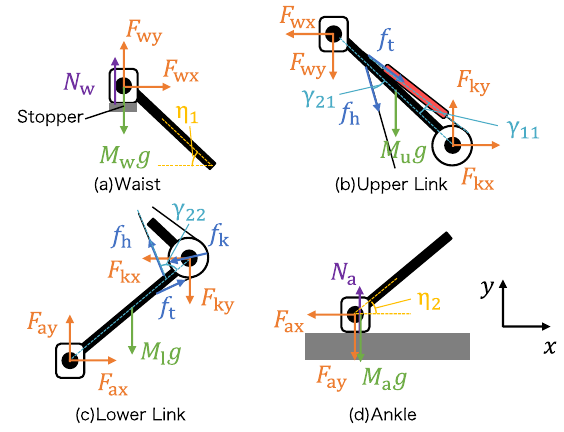
Fig. 5 Forces acting on each part of the